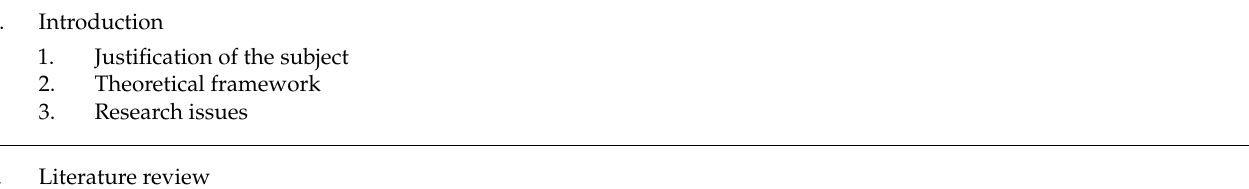
Table 2. Case-study protocol.